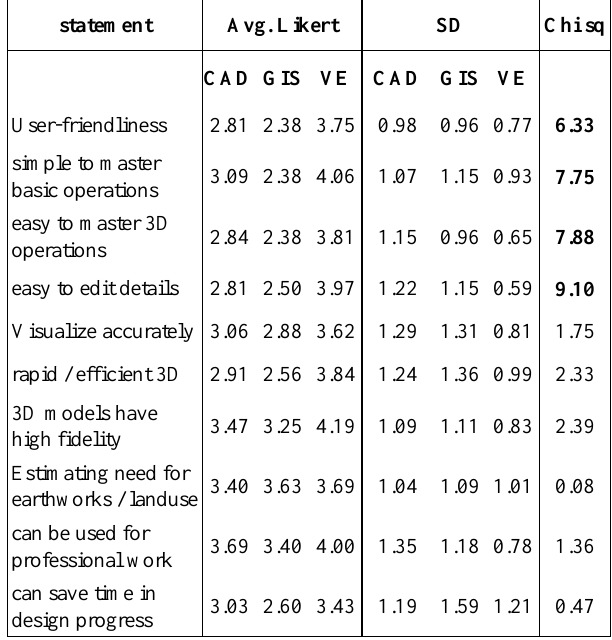
Table 2. Comparative satisfaction: Average and standard deviation of Likert scale scores (significant chi-squares in